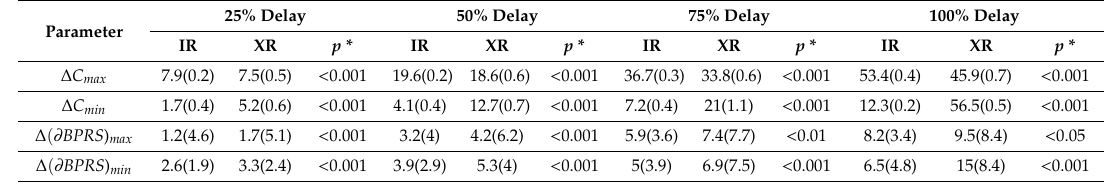
Table 1. E ff ect of Quetiapine dose delays on changes in pharmacokinetic (PK) and pharmacodynamic (PD) parameters relative to regular dose administration for the IR and XR formulations. Symbols are defined in